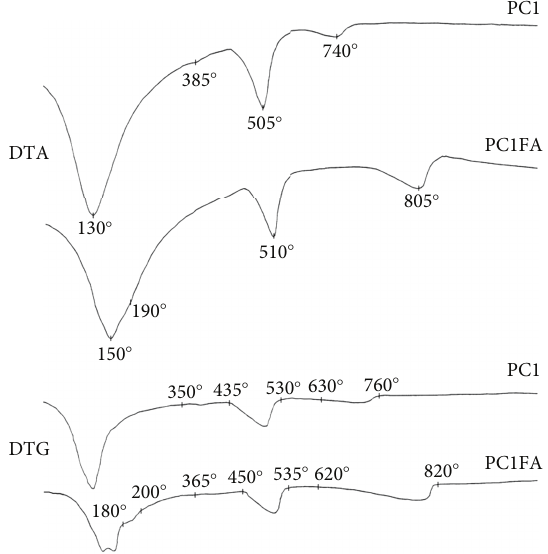
F 1: ermal effects registered on the 48th day of hydration of samples of cement pastes PC1 and PC1FA.